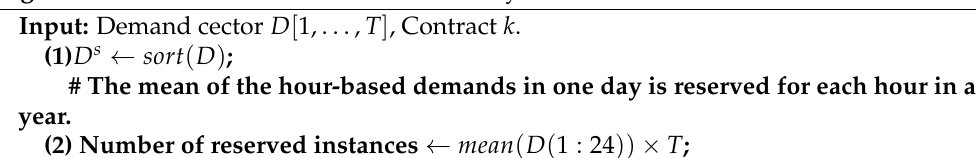
Algorithm 2 Mean-Resource Reservation